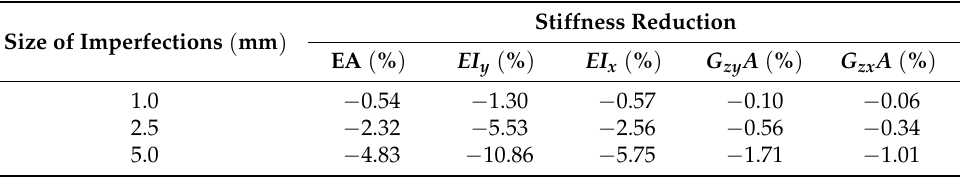
Table 6. Stiffness reduction of the Z profile with elongation of 100 mm due to bending about the vertical axis for (ii) case, depending on the size of